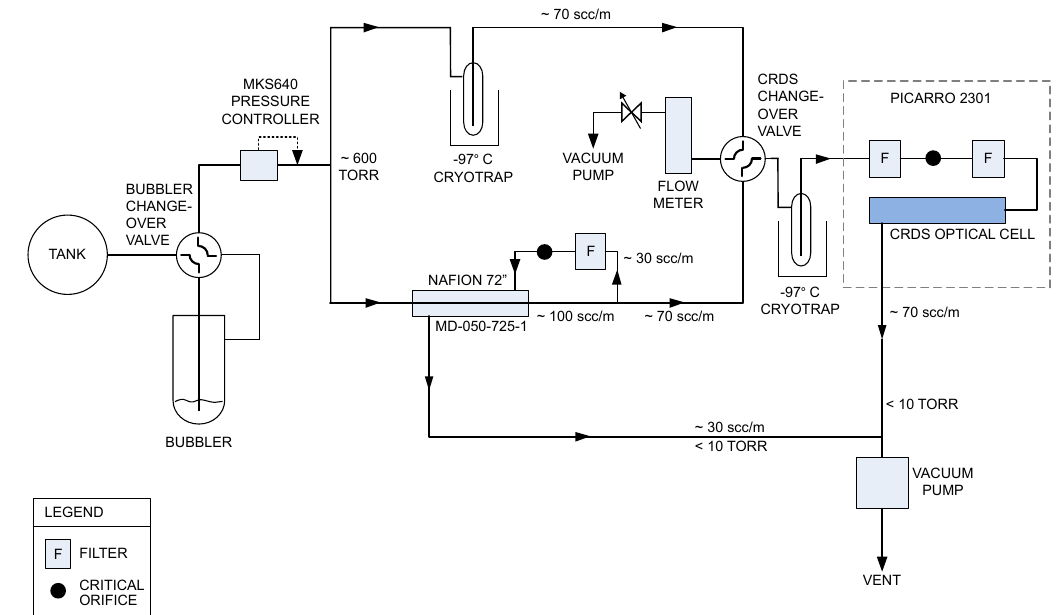
Fig. 2. Experimental test setup for testing the Nafion dryer. Dry tank air is humidified with a bubbler. The Nafion and cryotrap treatments are continuously flowing and the CRDS changeover valve allows the CRDS analyzer to alternately monitor each one. The second cryotrap downstream of the CRDS changeover valve was added after Exp. 1.1 and 1.2 to remove the residual water exiting the Nafion and eliminate the need to apply any water vapor correction. In the dry-air experiments the first cryotrap was either left at room temperature or removed. The downstream cryotrap was used to remove the residual water from the Nafion treatment, thus avoiding any H 2 O / CO 2 interaction on surfaces within and immediately upstream of the